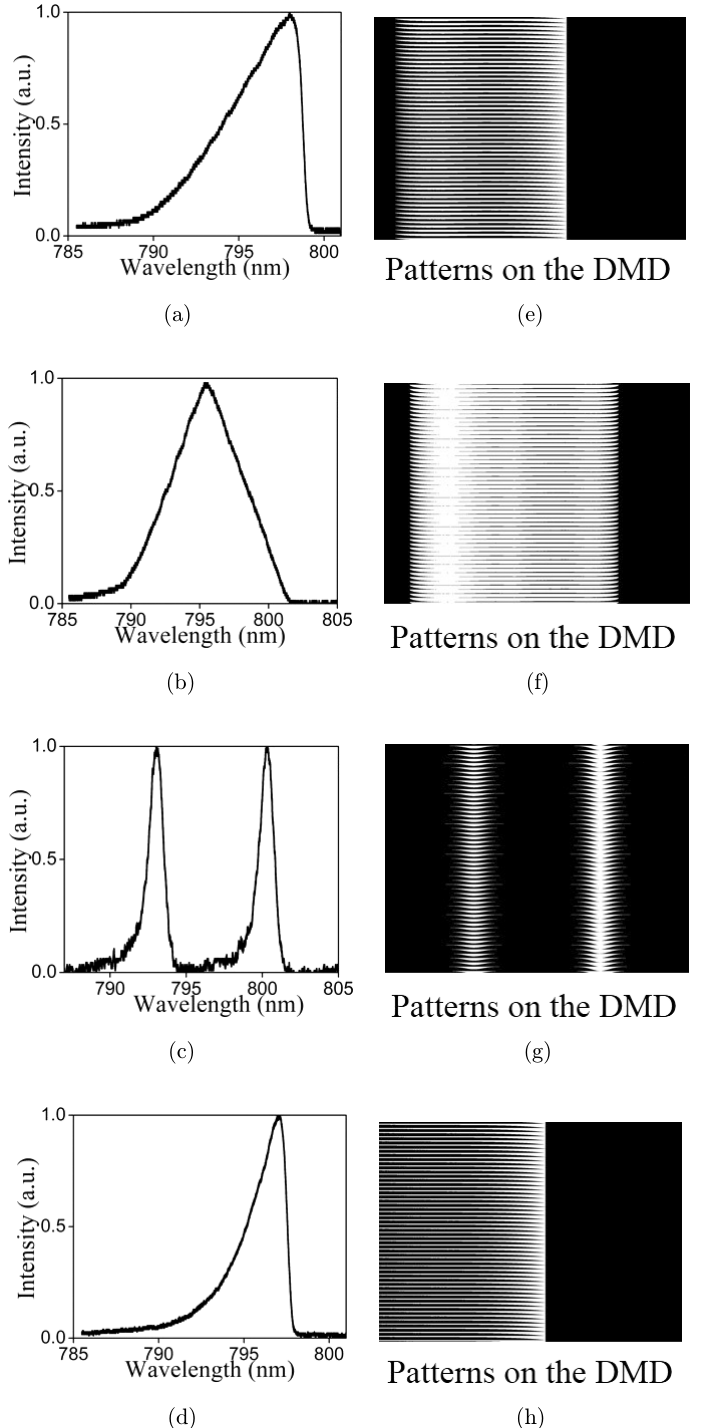
Fig. 5. (a) – (d) Shaped spectra with sawtooth, triangular, double-pulse, and exponential pro¯les, respectively; (e) – (h) corre- sponding patterns on the